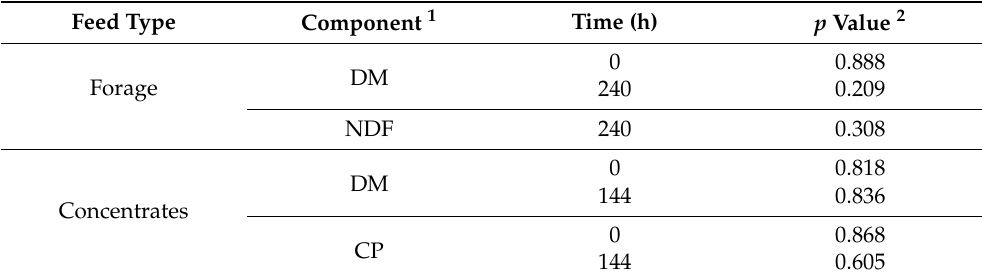
Table 2. Evaluation of the variability among animals regarding the non-degraded fractions obtained in the initial (0 h) and final (144 h for concentrates and 240 h for forage) incubation times according to the type of feed and evaluated